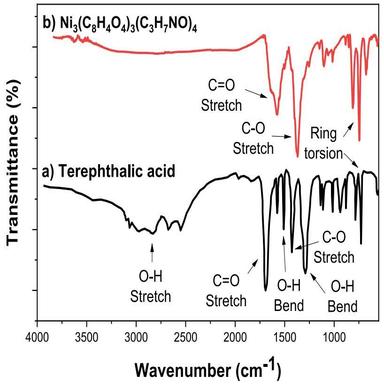
The IR spectra of (a) Terephthalic acid (H2BDC), black line and (b) Ni3(C8H4O4)3(C3H7NO)4, red line.